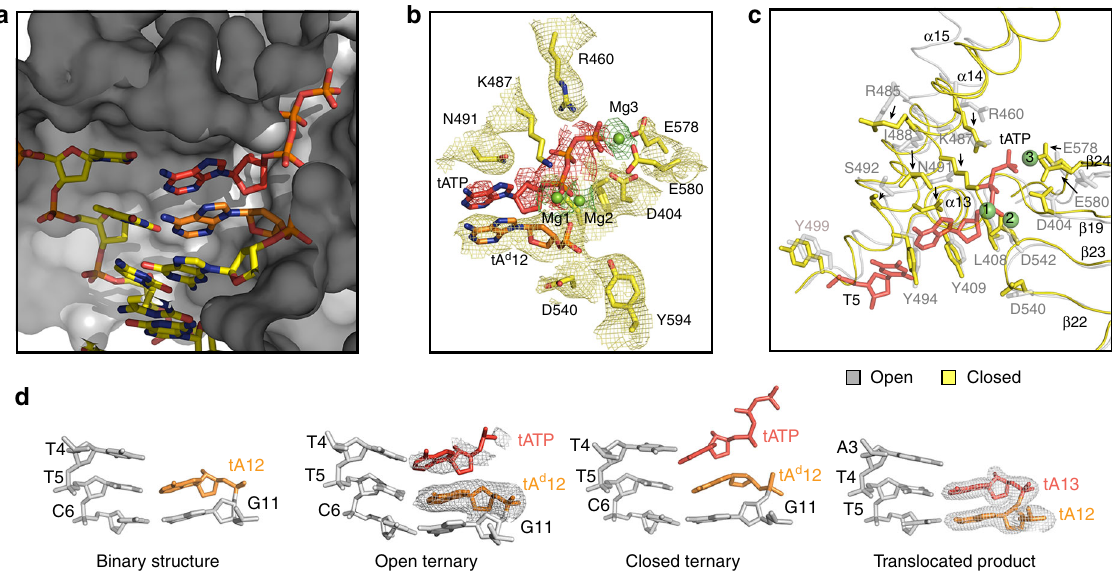
Fig. 4 Active site pocket. a Surface representation of the enzyme-active site in the closed ternary conformation of Kod-RI. b Superimposed on the stick model from (A) is a 2Fo – Fc composite omit map (yellow) contoured at 1.0 σ for the conserved residues and tA d 12 and two simulated annealing Fo – Fc omit maps contoured at 2.0 σ for tATP and the three magnesium ions (red and green, respectively). c Structural differences observed between the open and closed conformations of the ternary complex. d Stick models comparing the Watson – Crick base pairing geometry for a portion of the P/T duplex. Simulated annealing Fo – Fc omit maps contoured at 3.0 σ and 4.0 σ are shown for the open ternary complex and the translocated product, (Mg 1 ), located between the α -phosphate of tATP and the primer